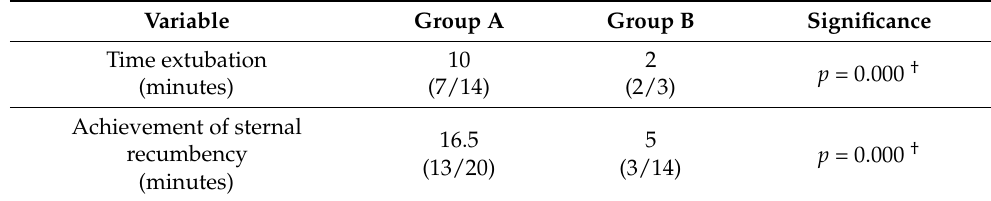
Table 4. Time extubation and achievement